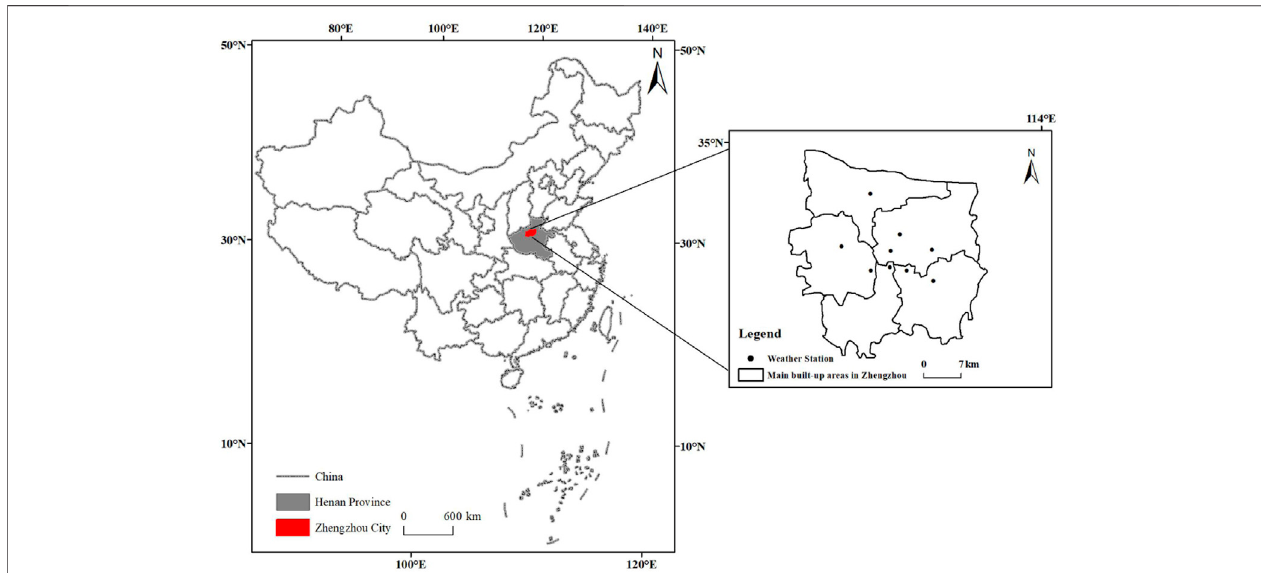
FIGURE 1 | Distribution map of meteorological observation stations in zhengzhou